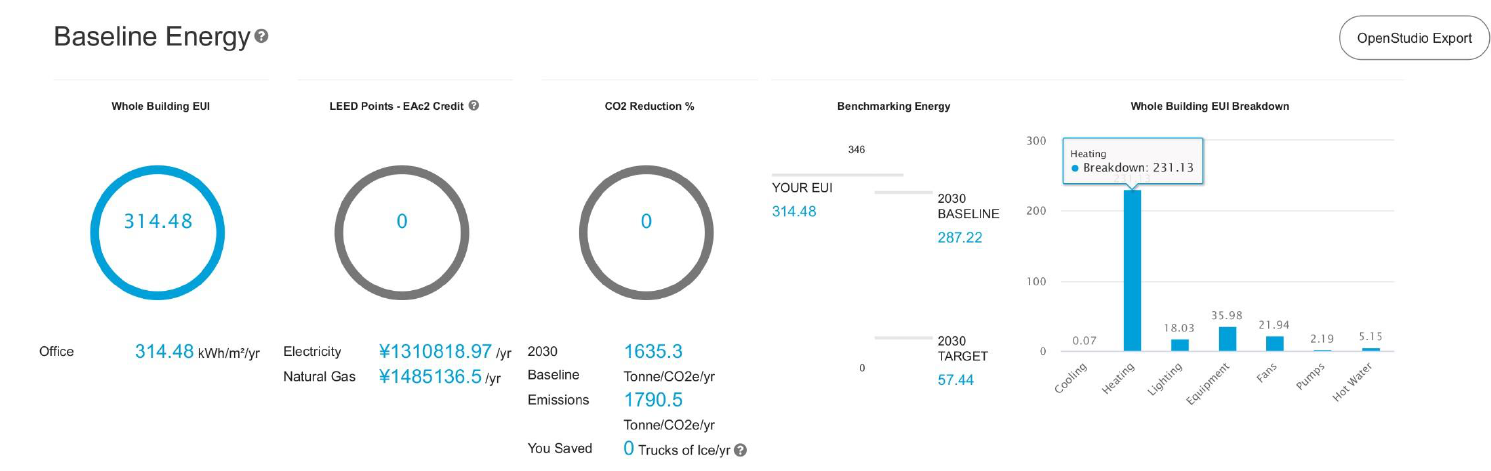
Figure A28. Zone 5-H Lhasa, Xizang (pre-COVID-19 scenario).